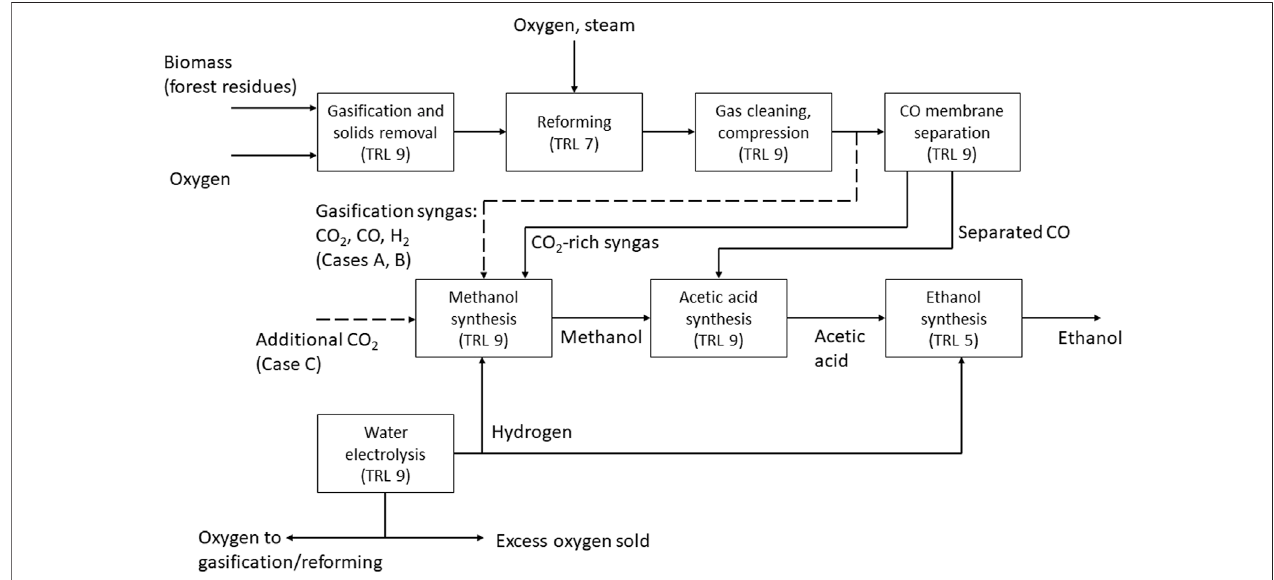
FIGURE 1 | Block diagram of the process in Cases A – C, with technical readiness levels (TRL) for the process steps. Solid lines represent connections valid for all cases, dashed lines represent speci fi c connections.